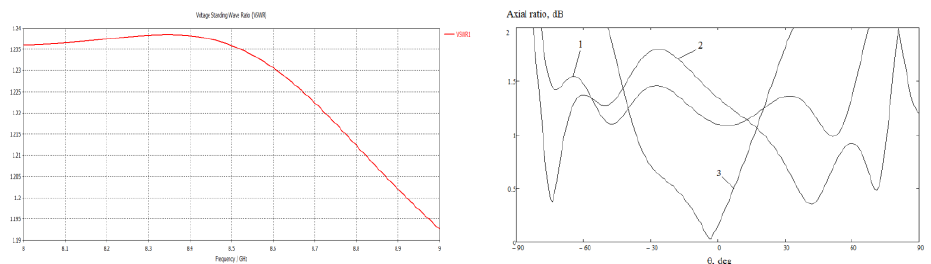
Fig. 2. Dependence of SWR on frequency. Fig. 3. Dependencies of the ellipticity coefficient on angular coordinates.